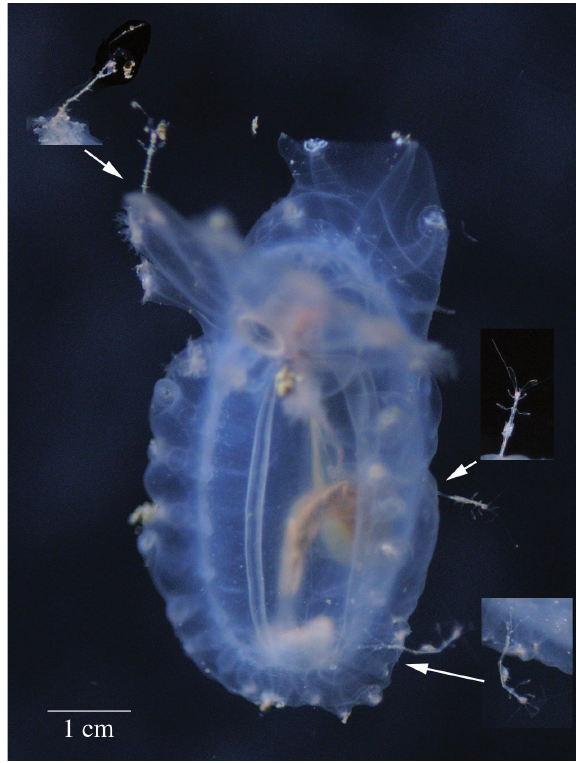
Fig . 2. – Photograph of Ellipinion kumai (Mitsukuri, 1912) in the aquarium showing the attachment sites of the three Caprella subti- lis individuals. insets show the individuals’ respective macromor-